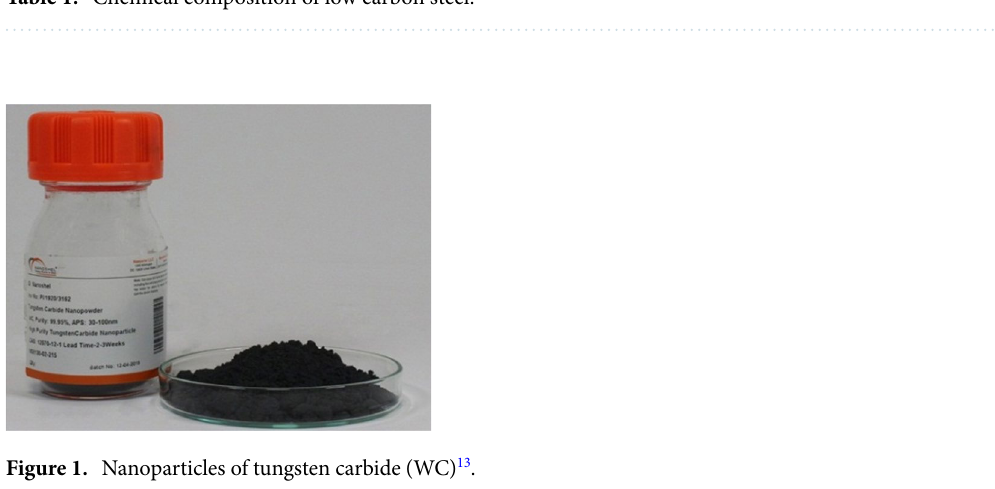
Table 1. Chemical composition of low carbon steel.